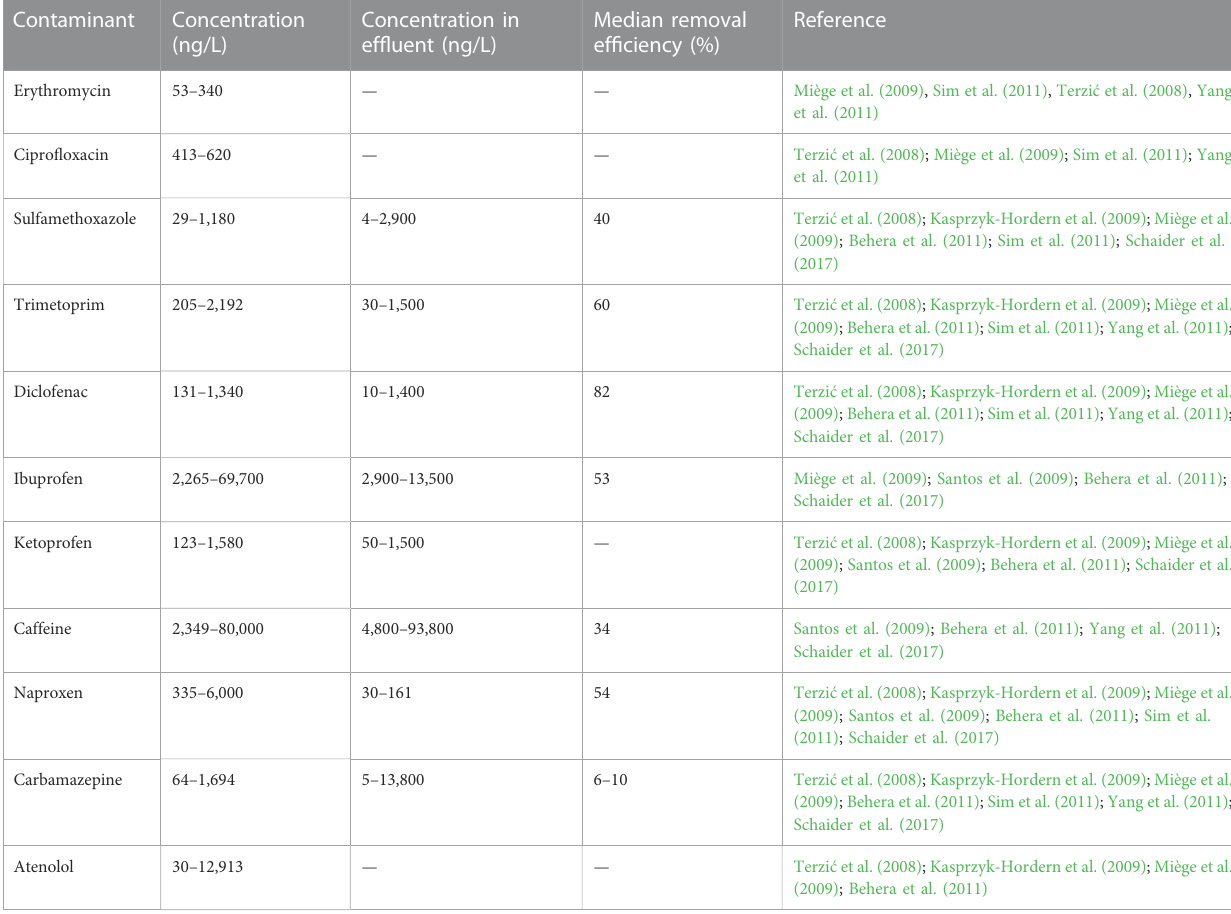
TABLE 3 Pharmaceutical and personal care products detected in domestic wastewater, concentrations in ef fl uent of onsite systems, and removal ef fi ciencies by onsite systems.